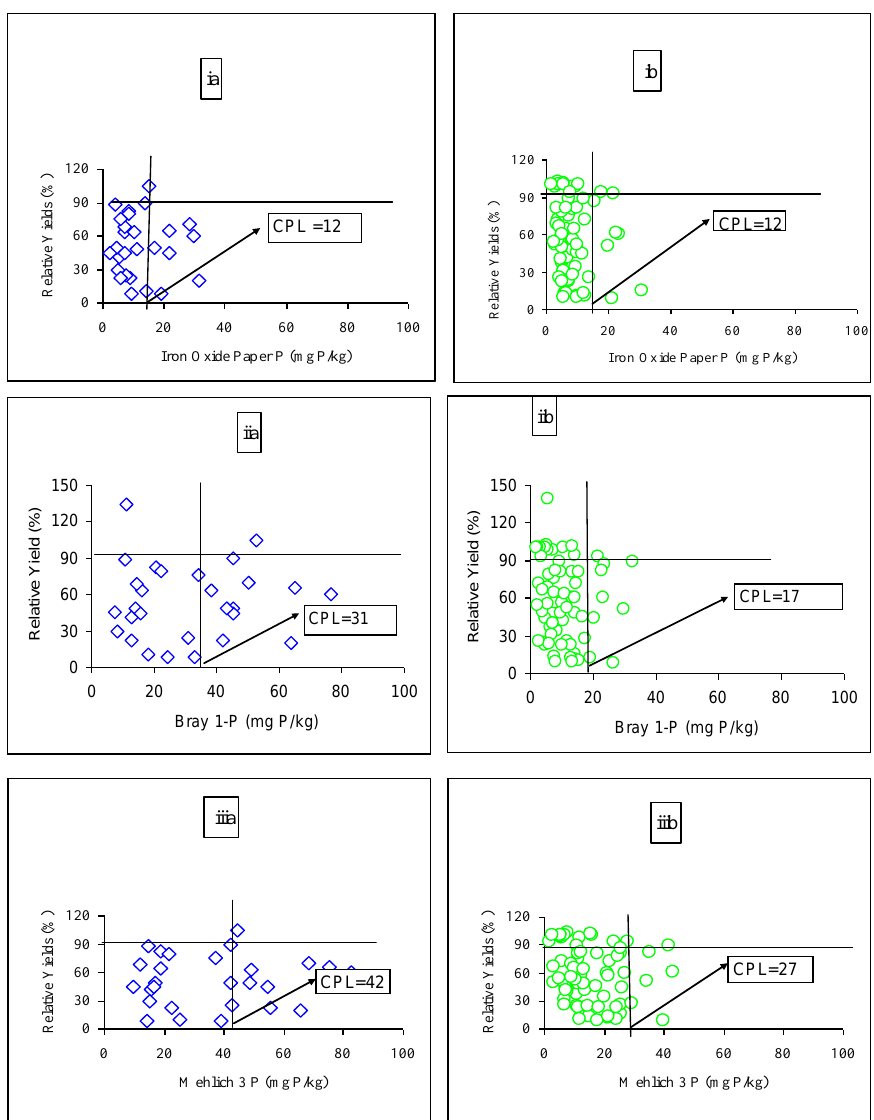
FIGURE 4. CPLs for the P sources (a) TSP- and (b) PR-fertilized soils for the test methods: (i) strip, (ii) B1, and (iii) Meh3. Arrow: denotes the CPL